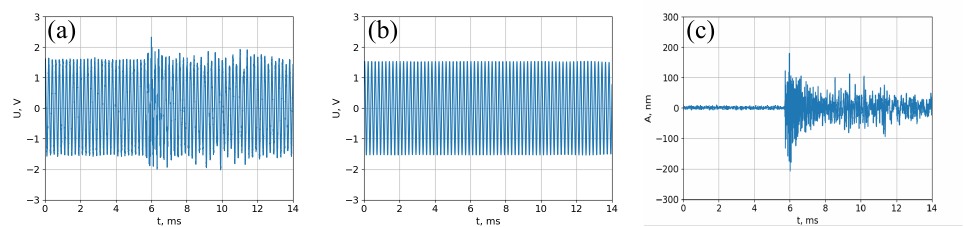
Figure 4. Signal processing. ( a ) Full signal at the output of the photodetector. ( b ) Filtered first harmonic of modulation frequency. ( c ) The detected acoustic signal.